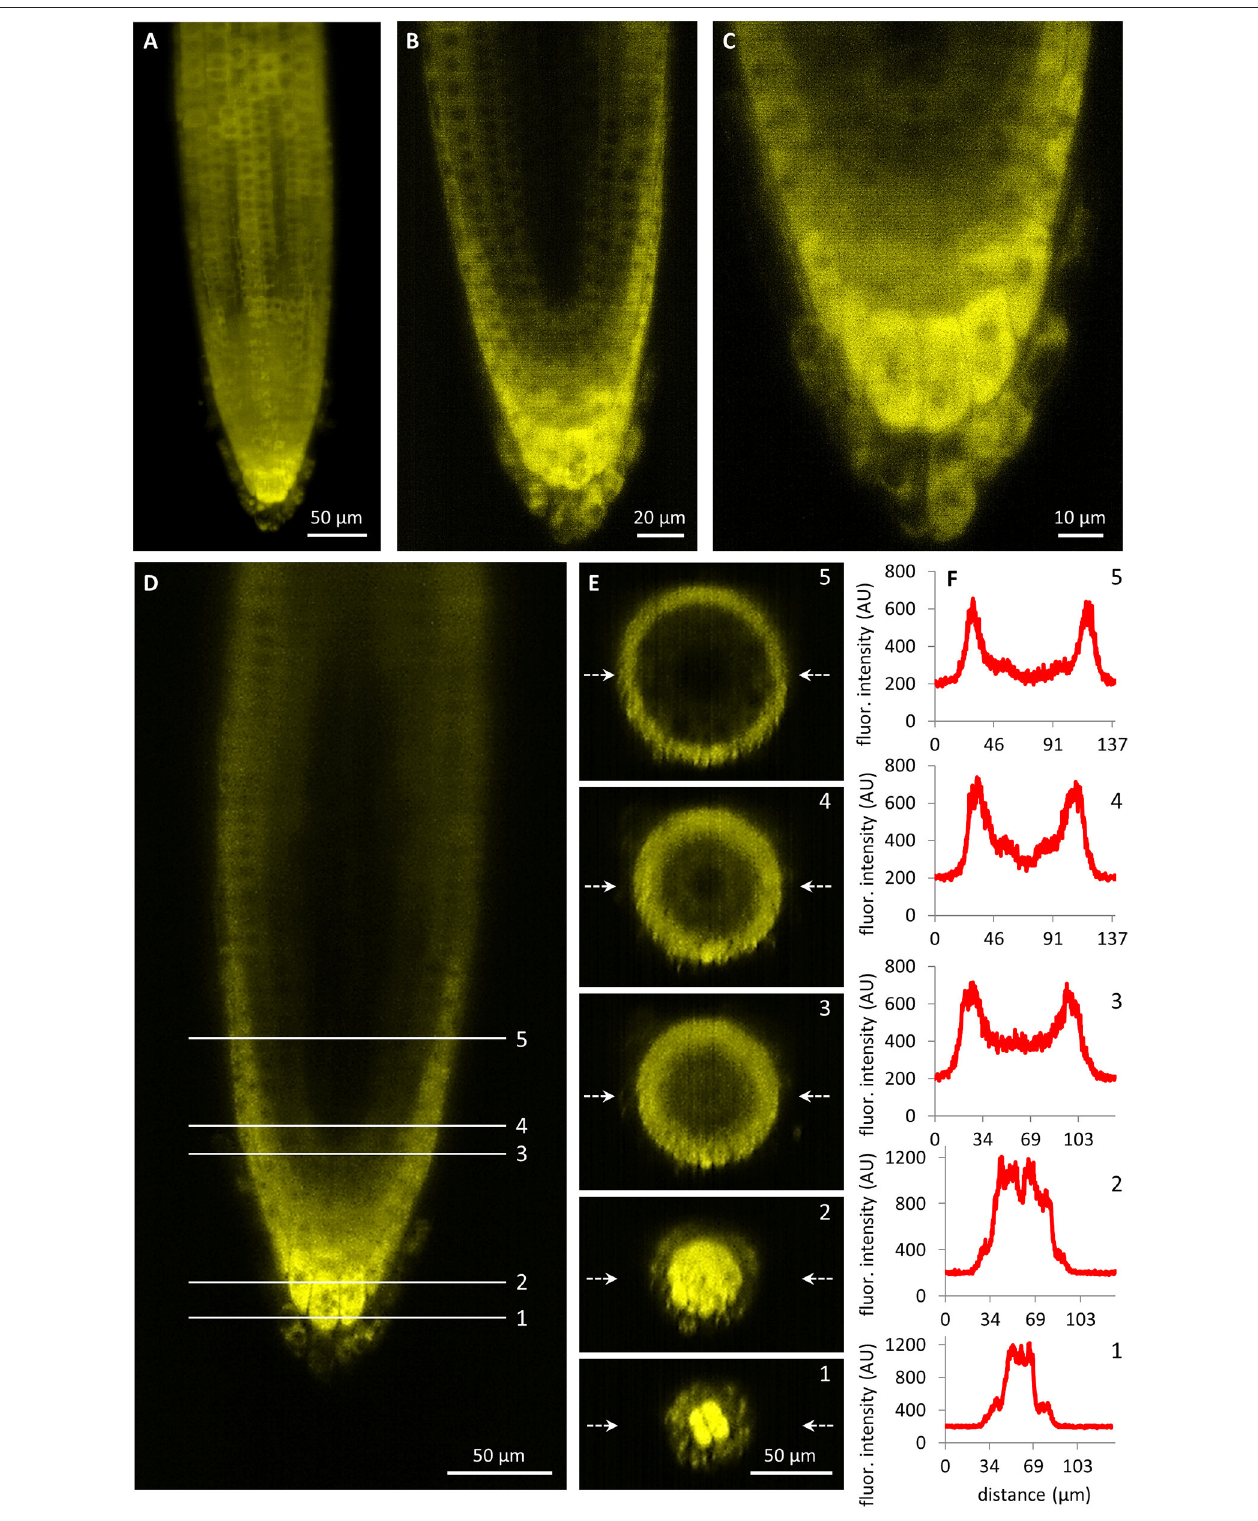
FIGURE 3 | Light-sheet fluorescence microscopy localization of PLD α 1-YFP driven by PLD α 1 own promoter in Arabidopsis thaliana roots. (A) Overview of PLD α 1-YFP localization in different tissues of the root tip constructed from maximum intensity projection of 330 optical sections (with thickness of 0.5 µ m each).